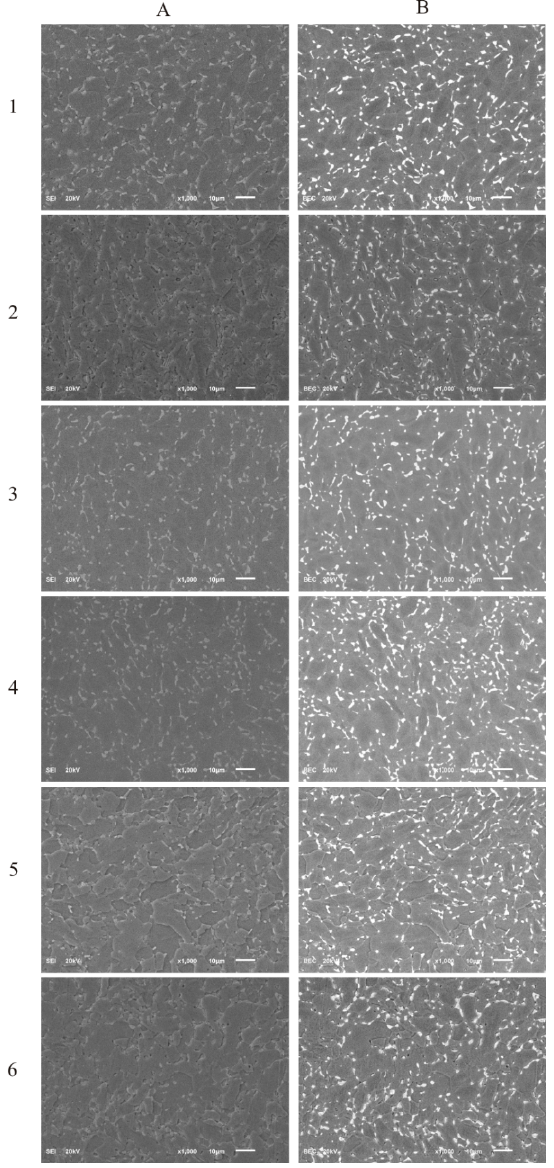
Figure 1. The scanning electron microscopy (SEM) images of the deposited coatings: ( A ) secondary electron imaging; ( B ) backscattered electron imaging, ( 1 ) diamond-like carbon (DLC), ( 2 ) Si-DLC 0, ( 3 ) Si-DLC 1, ( 4 ) Si-DLC 2, ( 5 ) Si-DLC 3, ( 6 ) Si-DLC 4.